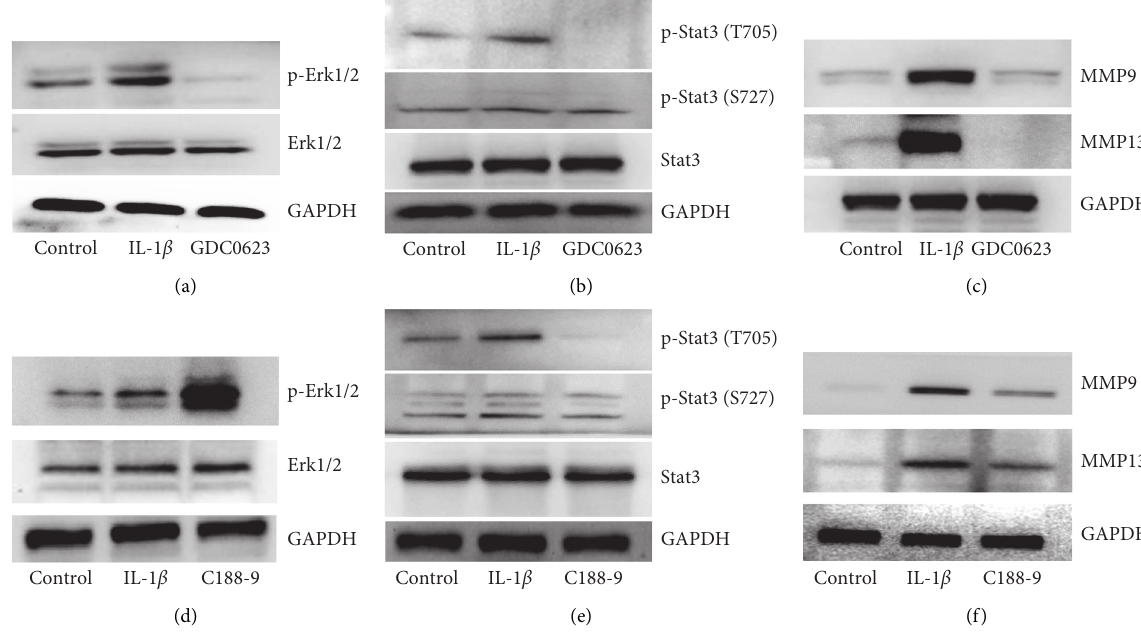
Figure 6: Effects of GDC0623 and C188-9 on MEK-Erk1/2 and Jak-Stat3 signaling pathways and on expression levels of MMP9 and MMP13. Osteoblasts were pretreated with DMEM plus 0.1% FBS overnight and intervened with IL-1 β , IL-1 β plus GDC0623, and IL-1 β plus C188-9 for 60min. (a–c) Protein levels of p-Stat3, P-Erk1/2, MMP9, and MMP13 were analyzed after IL-1 β -stimulated osteoblasts had been treated with GDC0623. (d–f) Expression levels of p-Stat3, P-Erk1/2, MMP9, and MMP13 were assessed by blocking the Jak-Stat3 pathway with